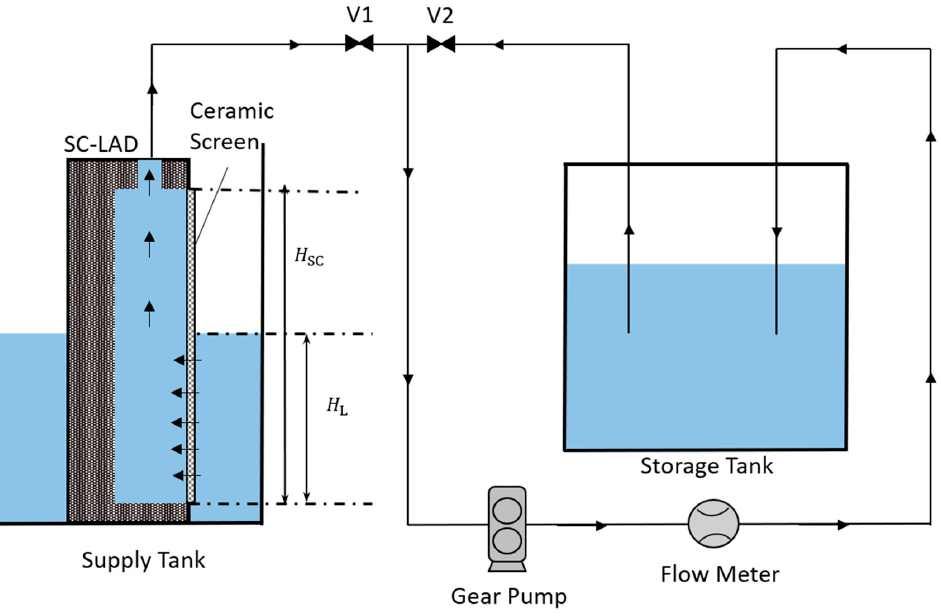
Figure 3. Setup used for testing phase separation. A SC-LAD was placed in a supply tank and the liquid was removed with a constant flow rate with the pump through the SC-LAD to the storage tank.